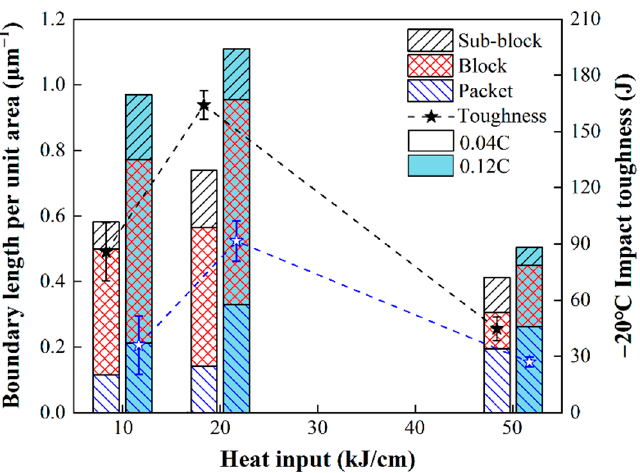
Figure 10. Relationship between boundary density and impact toughness of the simulated samples at the heat input of 10, 20 and 50 kJ/cm.